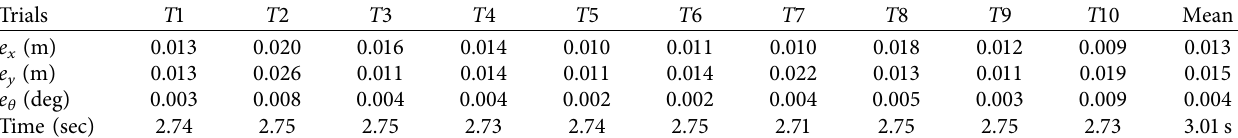
Table 12: The mean of different trials with the PF (one landmark and non-Gaussian noise).